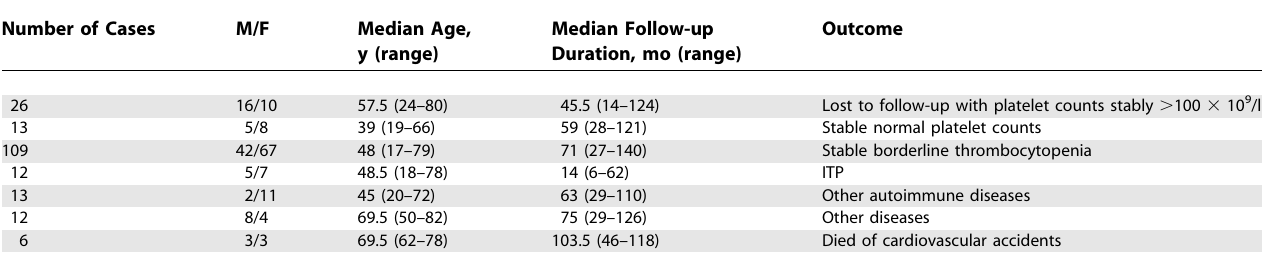
Table 4. Outcome of Individuals with Borderline Thrombocytopenia Followed after the Initial 6-mo Observation Period Number of